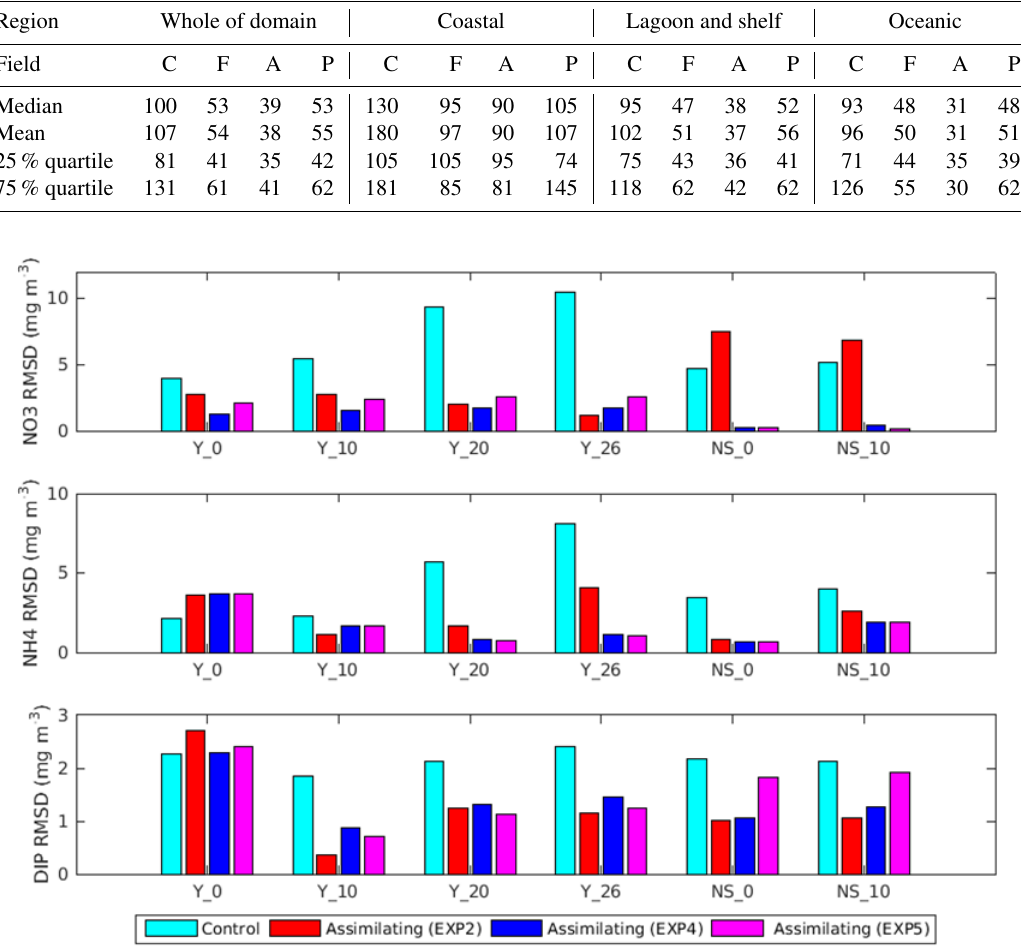
Figure 11. A comparison of RMSD of simulated nutrients with in situ bottle samples for the non-assimilating (cyan) and assimilating run of EXP2 (red), EXP4 (blue) and EXP5 (magenta). Observations are obtained at the Queensland IMOS site (yellow triangles in Fig. 1) at Yongala (Y) and North Stradbroke (NS) Island. Y_0 are the Yongala surface samples, while Y_26 are the samples taken from 26m